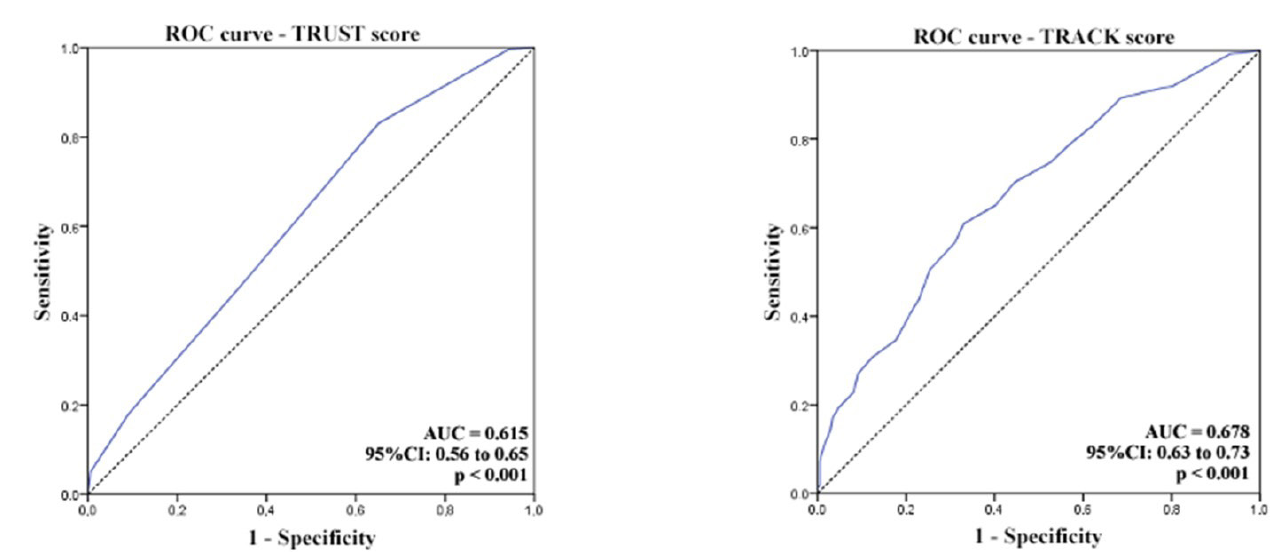
Fig. 1 - Receiver operating characteristic (ROC) curves and respective area under the ROC curve (AUC) of Transfusion Risk Understanding Scoring Tool (TRUST) and Transfusion Risk and Clinical Knowledge (TRACK) scores. CI=confidence